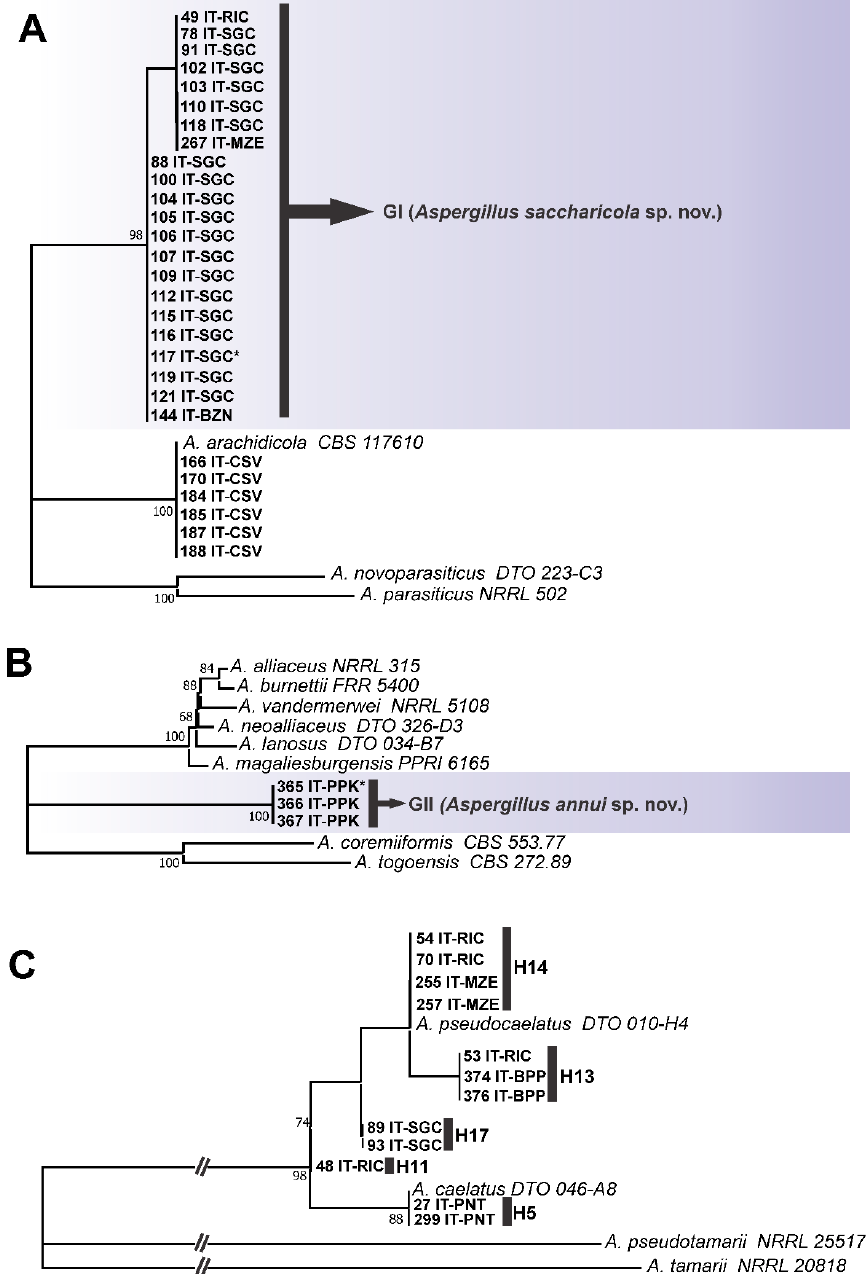
Figure 5. Unrooted coalescent species trees estimated using ASTRAL-II. ( A ) Aspergillus parasiticus clade; ( B ) Alliacei and Coremiiformes series; ( C ) ser. Kitamyces . Only bootstraps ≥ 60% are shown. * = type strains of the new species described in this study.